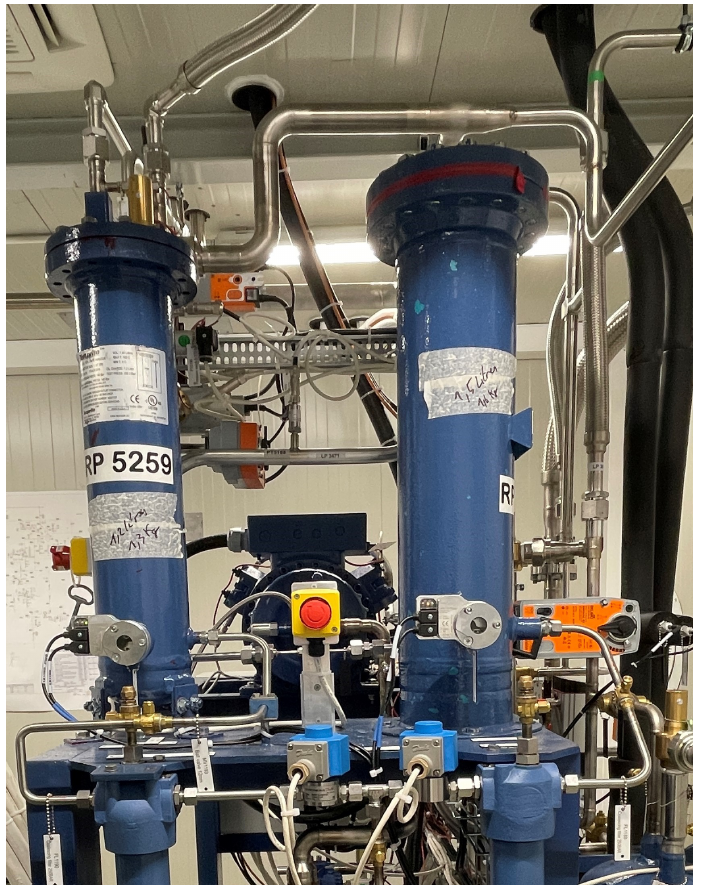
Figure 7. Coarse and fine oil separators installed in one of the compressor